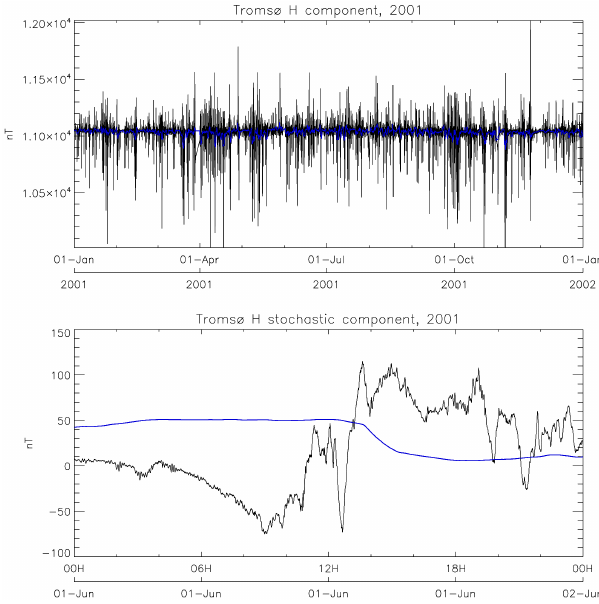
Figure 1. H component of geomagnetic field from Tromsø (70 ◦ N, 19 ◦ E) for the year 2001. Data are at 10s time resolution. The top panel shows the original data in black with a 1-day smoothing su- perimposed in blue. The bottom panel shows a detail of the residual – the result of subtracting the smoothed time series from the original – for 1 June and with the mean-subtracted 1-day smoothing, again superimposed in